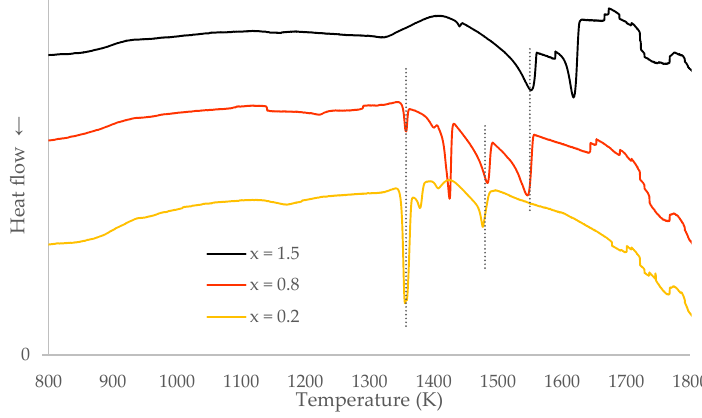
Figure 1. DSC cooling curves of as-cast Al x CoCrFeNiTi alloy.